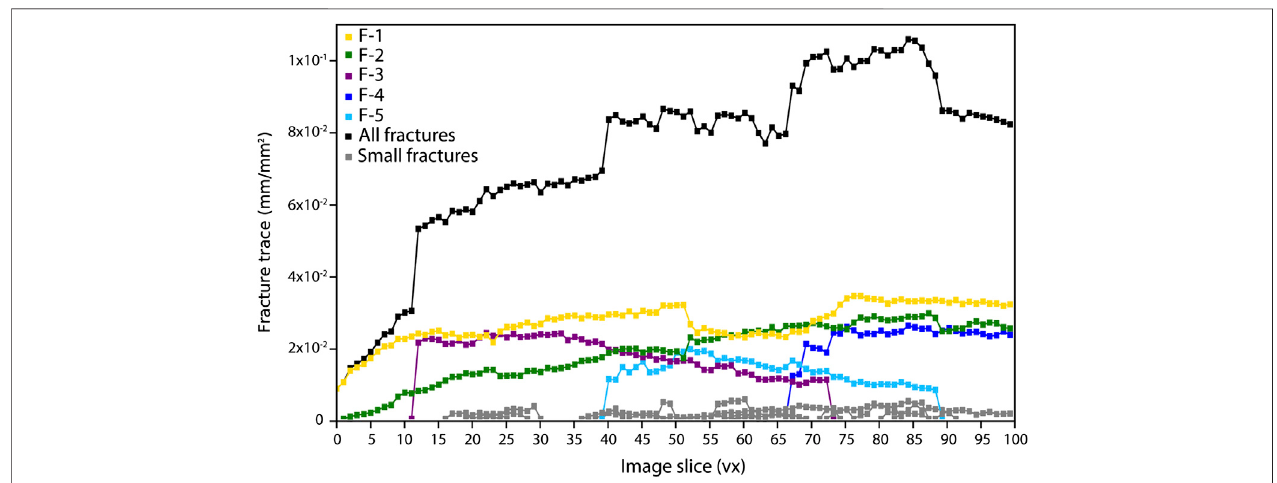
FIGURE8| Two-dimensionalfractureintensityvariationacrossthecore(P 22 )forthewholefracturesystem(black line)and individualfractures(colored lines).P 22 is measured for each slice as the total fracture trace length divided by trace plane area (mm/mm 2 ).